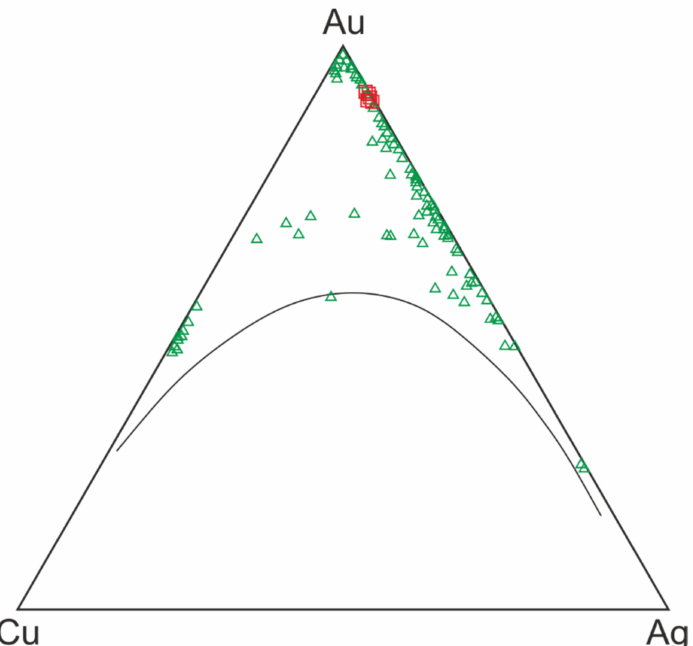
Figure 9. Composition of placer gold from the placer of the Gule River (green triangles) and bedrock gold particles from olivine rocks (red squares)